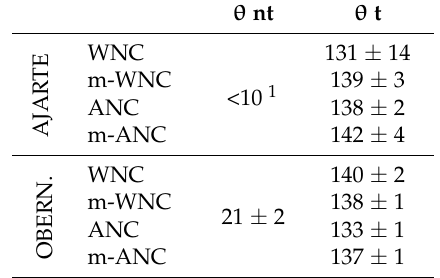
Table 8. Values of static contact angle ( θ , ◦ ) of water before (nt) and after (t) treatment with WNC, m-WNC, ANC and m-ANC for Ajarte and Obernkirchen stones. Values for treated stones are averaged on 2 specimens. θ nt θ